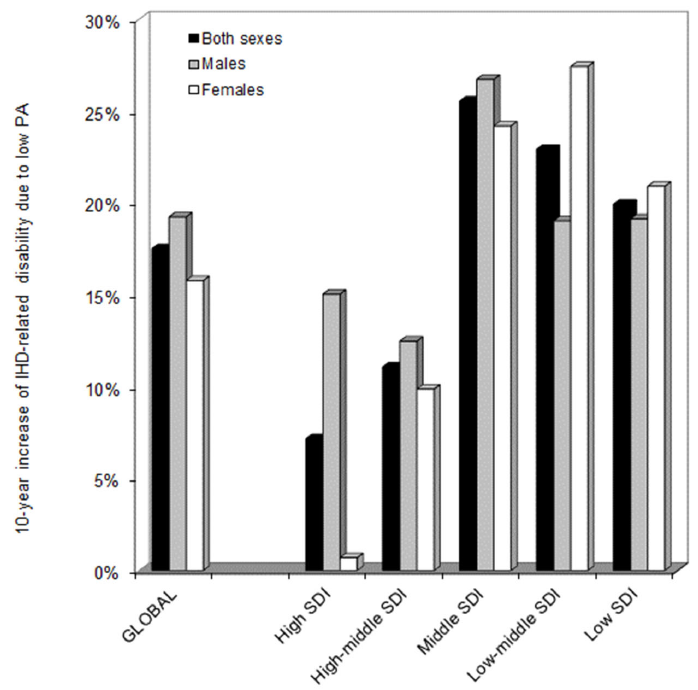
Figure 2. The 10-year relative increase in ischemic heart disease-related impairment that could be attributed to low physical activity in different socio-demographic index (SDI) areas based on data from the Global Health Data Exchange (GHDx) 2019 repository. IHD, ischemic heart disease; PA, physical activity; SDI, socio-demographic index.